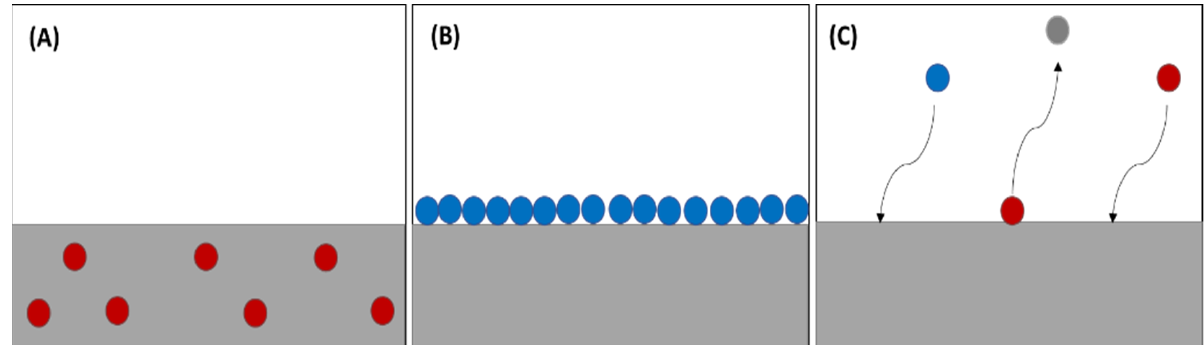
Figure 2. ( A ) Absorption process, ( B ) adsorption process, ( C ) sorption process. Table 1. Physical and absorption chemical [6,14].